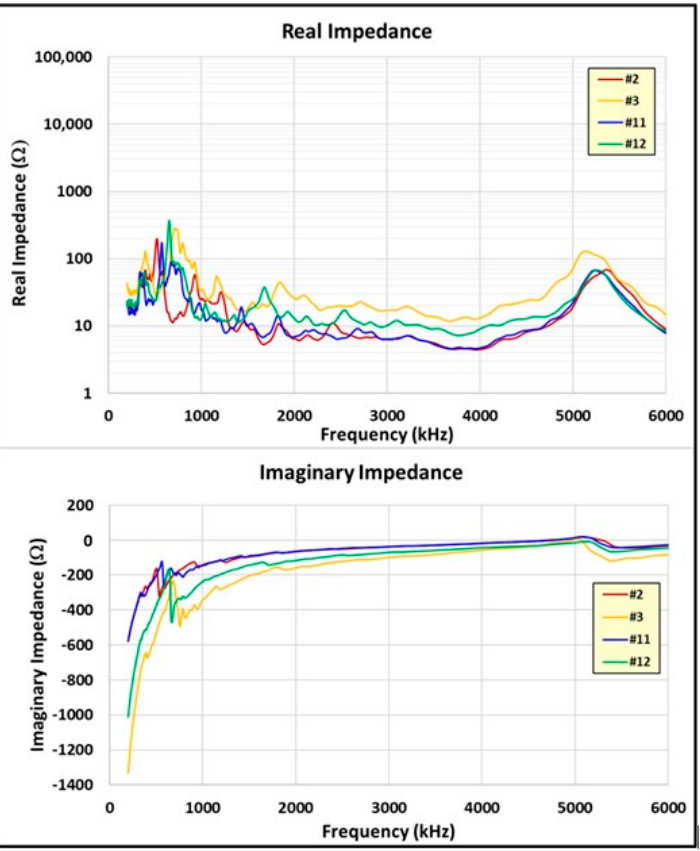
Figure 13. Pre-load test embedded sensor impedance resonances (Sensors 2, 3, 11, 12).